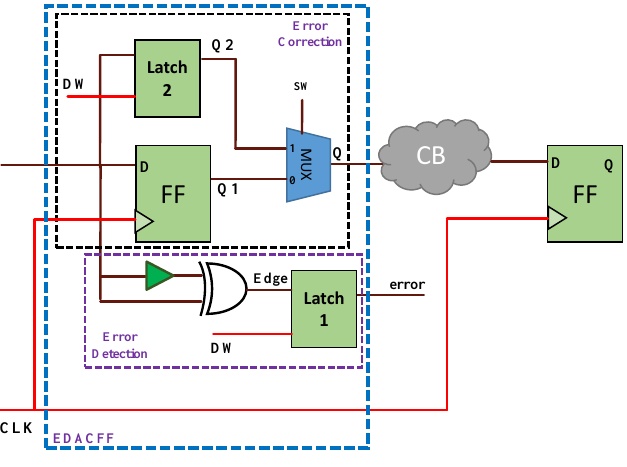
Figure 1. A proposed EDACFF on an FPGA.